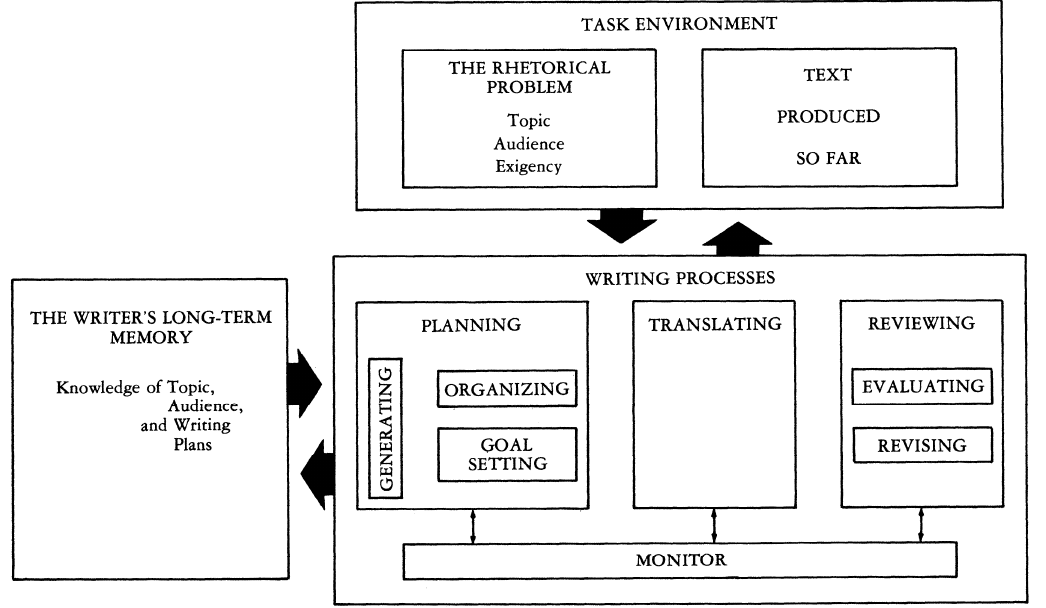
Figure 1. Flower and Hayes ʹ Cognitive Process Model (“A Cognitive Process Theory” p. 370) (used with permission).